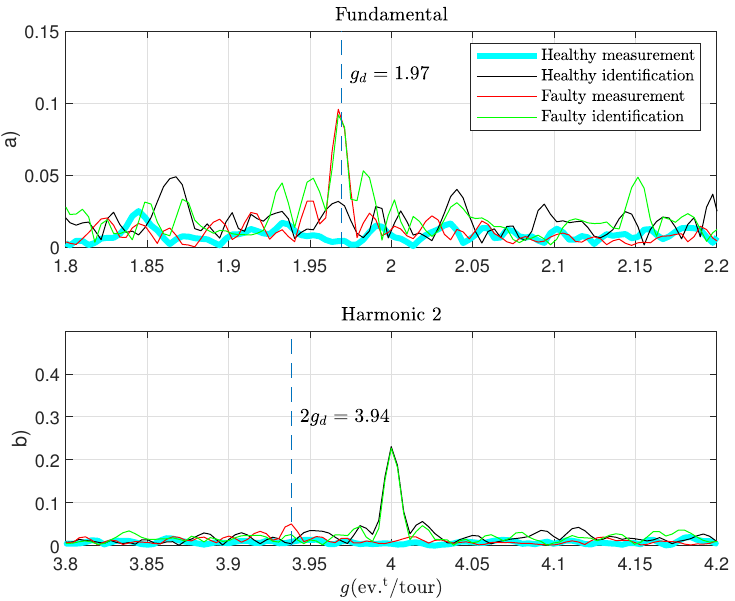
Figure 11. Zooms of angular spectrum of mechanical frequency around fault components. ( a ) be- tween 1.8 and 2.2 ev. t /rev, ( b ) between 3.8 and 4.2 ev. t